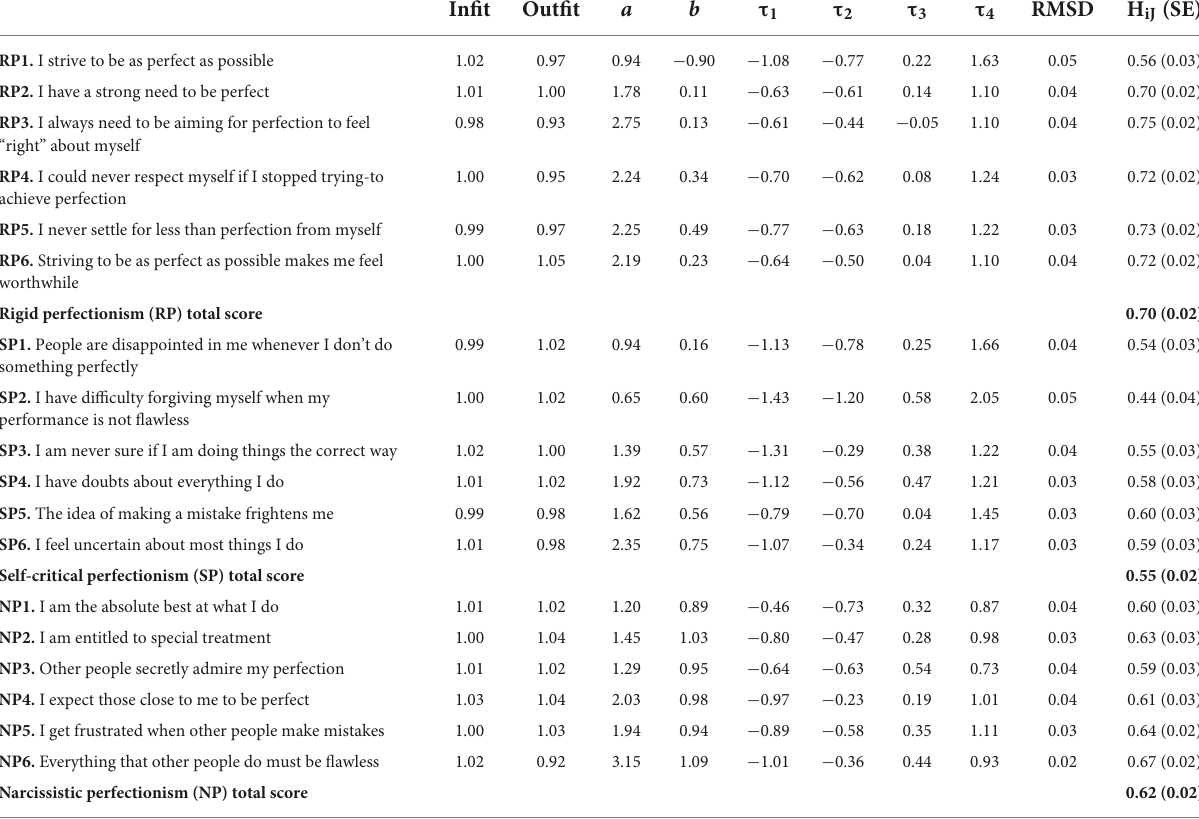
TABLE 1 The Big Three Perfectionism Scale–Short Form: Generalized partial credit model (GPCM) and Mokken scale analyses ( n = 401). Infit Outfit a b τ 1 τ 2 τ 3 τ